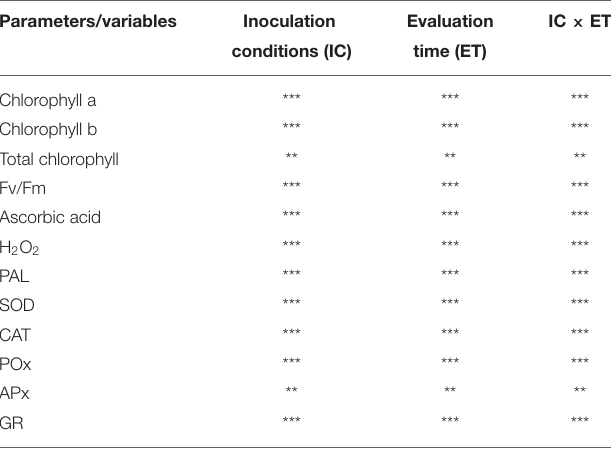
TABLE 1 | Variance analysis was done to examine the effect of ICs, ET, and their cumulative effect on chlorophyll a, chlorophyll b, total chlorophyll, Fv/Fm, AA, H 2 O 2 , SOD, PAL, CAT, POX, and APX (*** p < 0.001; ** p <